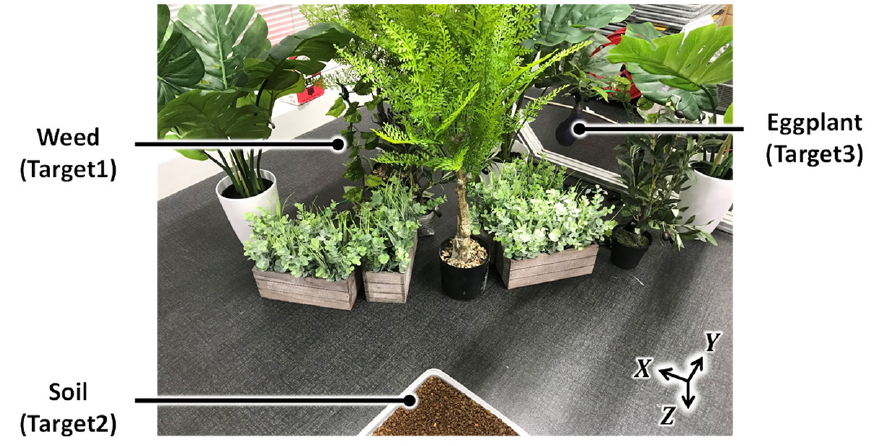
Figure 19. Laboratory experimental environment.